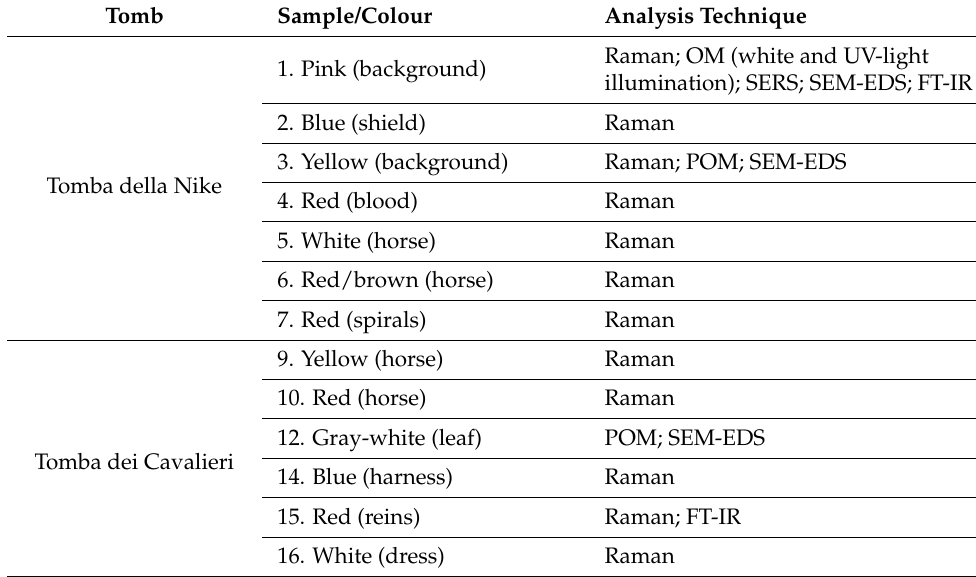
Table 6 summarizes the analytical techniques used in the analysis of each sample. Table 6. Analytical techniques used for each analysed sample. Tomb Analysis